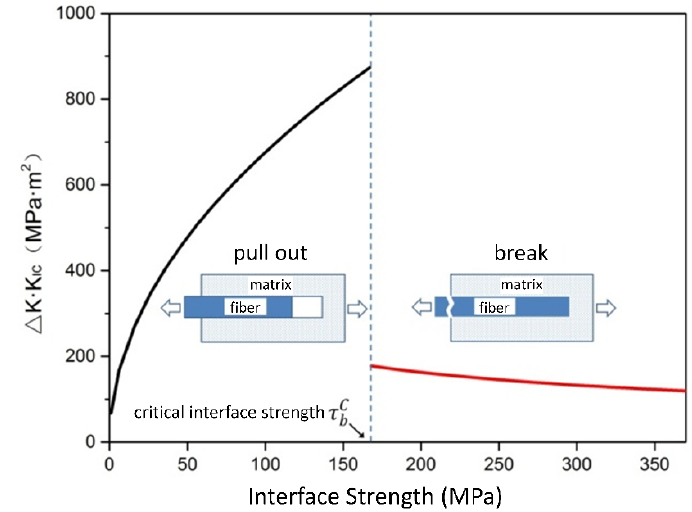
Figure 4. Fracture toughness enhancement of SiC–SiC as a function of fiber–matrix interface strength.